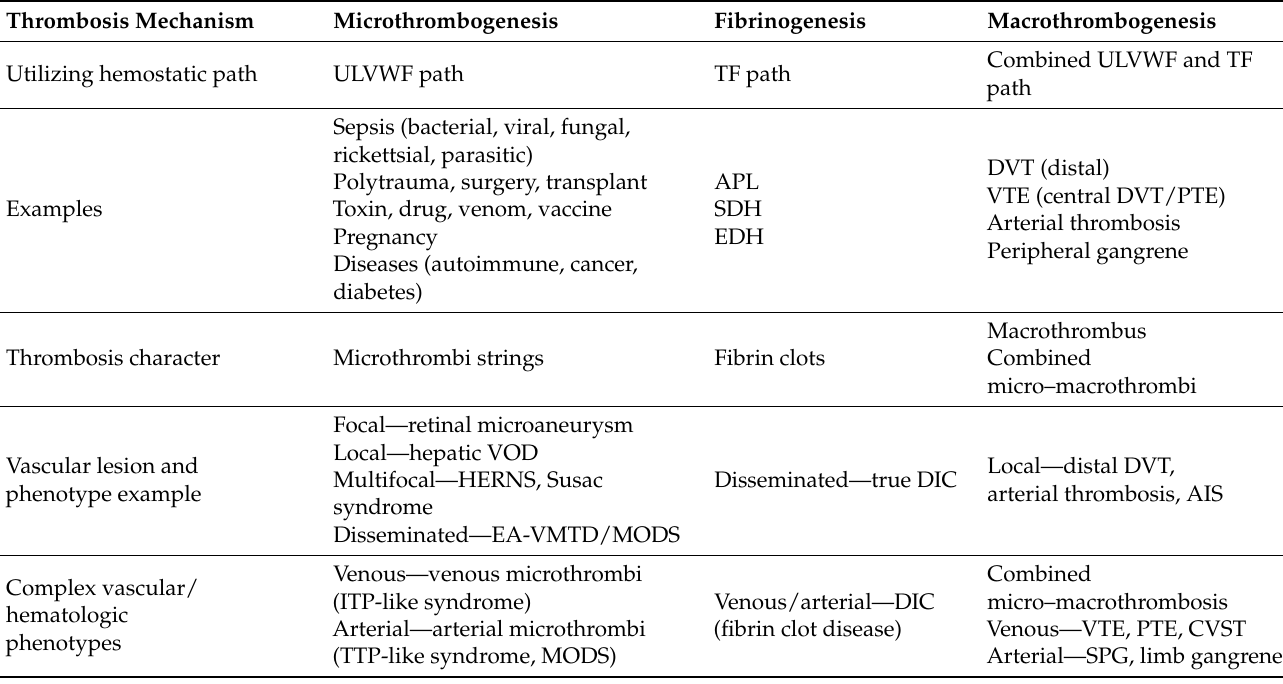
Table 3. Three thrombogenetic paths and their clinical phenotypes of thrombosis according to the “two-path unifying theory of